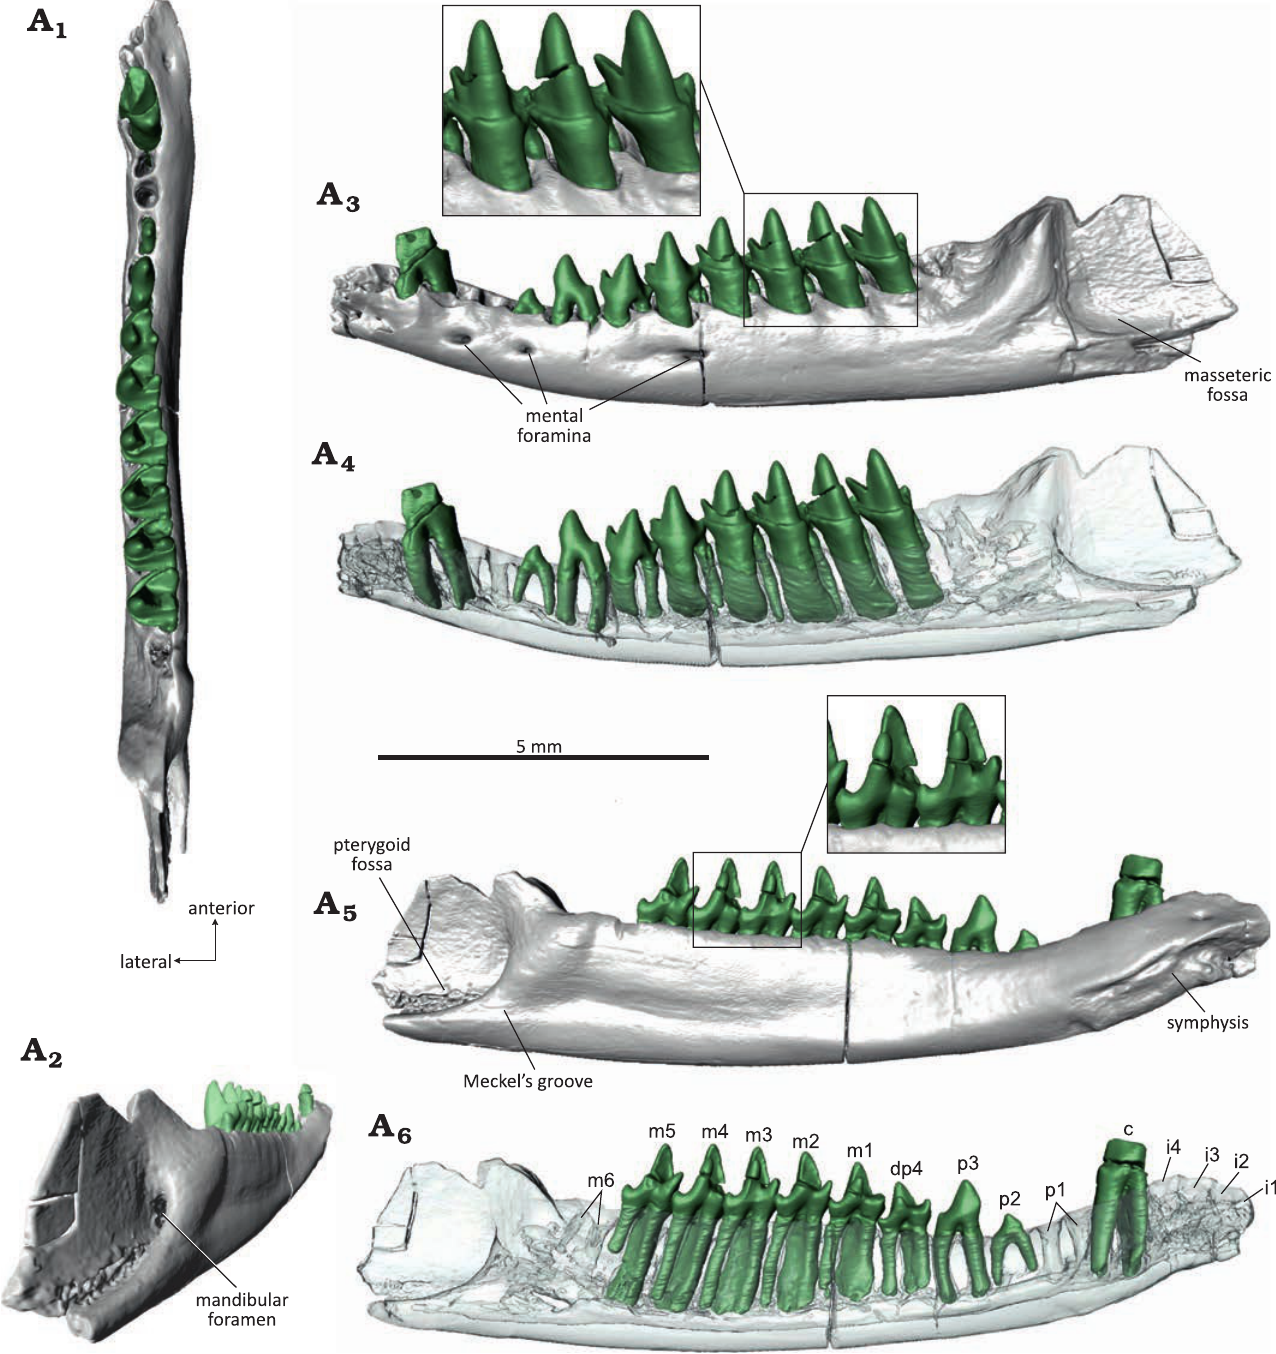
Fig. 11. Dryolestid mammal Crusafontia cuencana Henkel and Krebs, 1969, MfN Uña 1 (holotype) from Uña locality, province of Cuenca, Spain, Barremian (Lower Cretaceous). Left mandible in occlusal (A 1 ), linguoposterior (A 2 ), lateral (A 3 , A 4 ), and medial (A 5 , A 6 ) views. Inset in A 3 showing enlarged m3–m5 in labial view, inset in A 5 m3–m4 in ligunal view, A 6 with new interpretation of premolar and molar